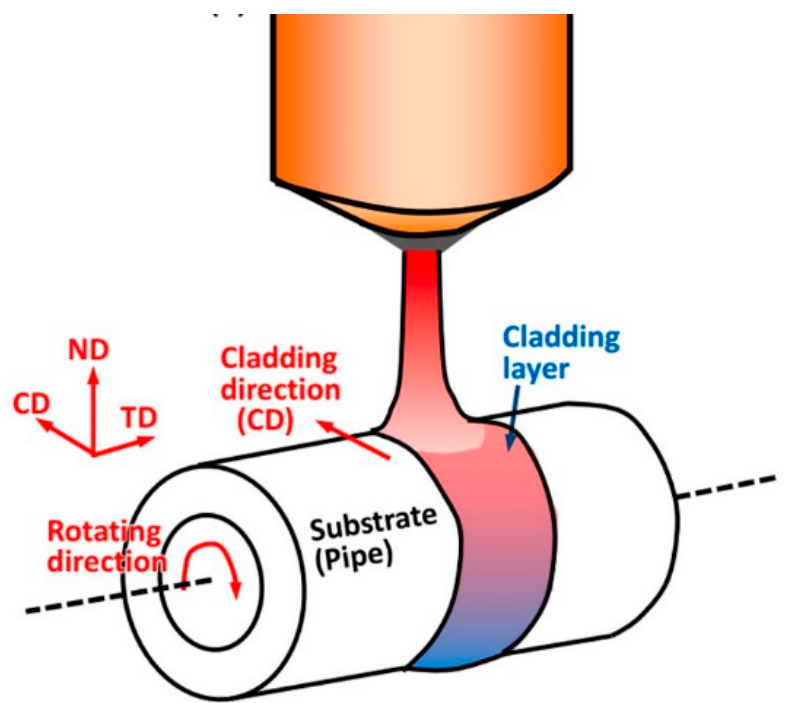
process. Reprinted with permission from Ref. [91]. Copyright 2020 Elsevier.